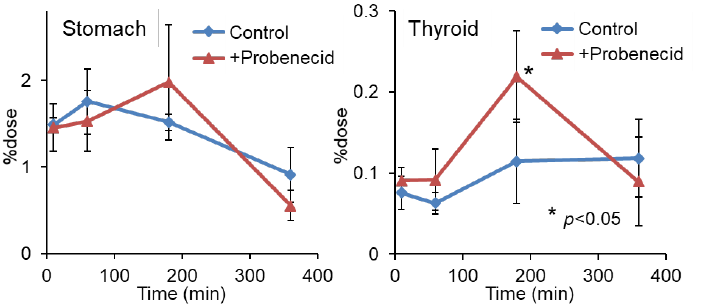
Figure 3. Stomach and thyroid radioactivity levels after injection of 2- 211 At-AAMP in normal mice with or without intraperitoneal injection of probenecid (mean ± SD, n = 4). * p < 0.05 compared with the control group (without probenecid preloading).